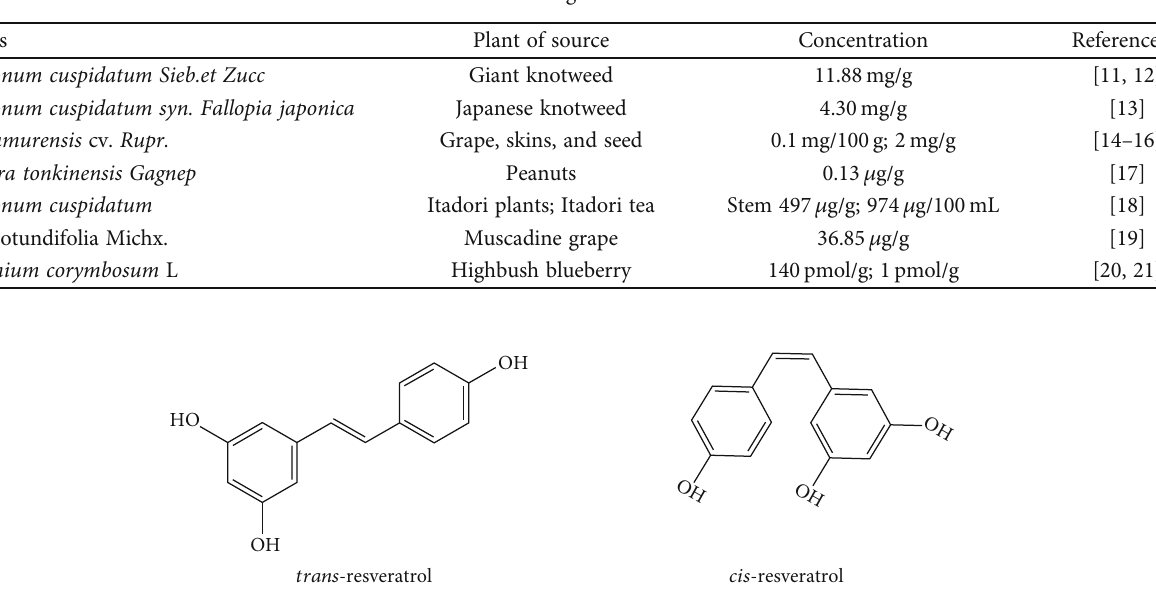
Table 1: Plant origin of resveratrol.